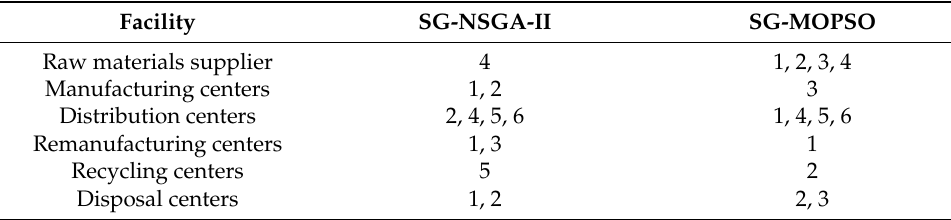
Table 6. The results of strategic scheme of the SCLSC network.